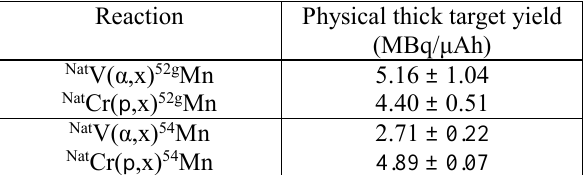
Table 1. Physical thick target yields for both 52g Mn and 54 Mn, produced by the reactions on Nat V and on Nat